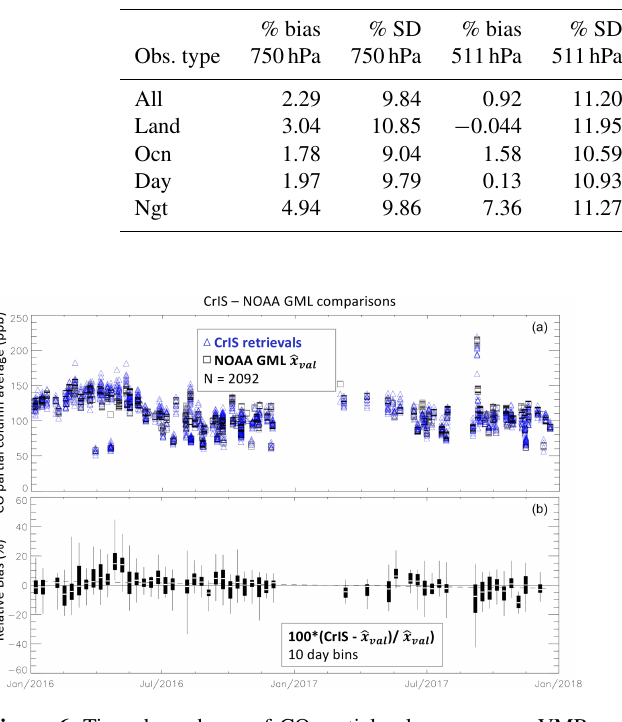
Figure 6. Time dependence of CO partial column average VMR (ppb) for TROPESS/CrIS retrievals and NOAA GML ˆ x val (a) as well as bias difference statistics (b) shown by box–whisker symbols representing minimum and maximum values (whisker), lower quar- tile (box bottom), median (white stripe), and upper quartile (box top). A minimum of five comparisons per bin was required. The dashed line indicates a fit for bias drift (see text).